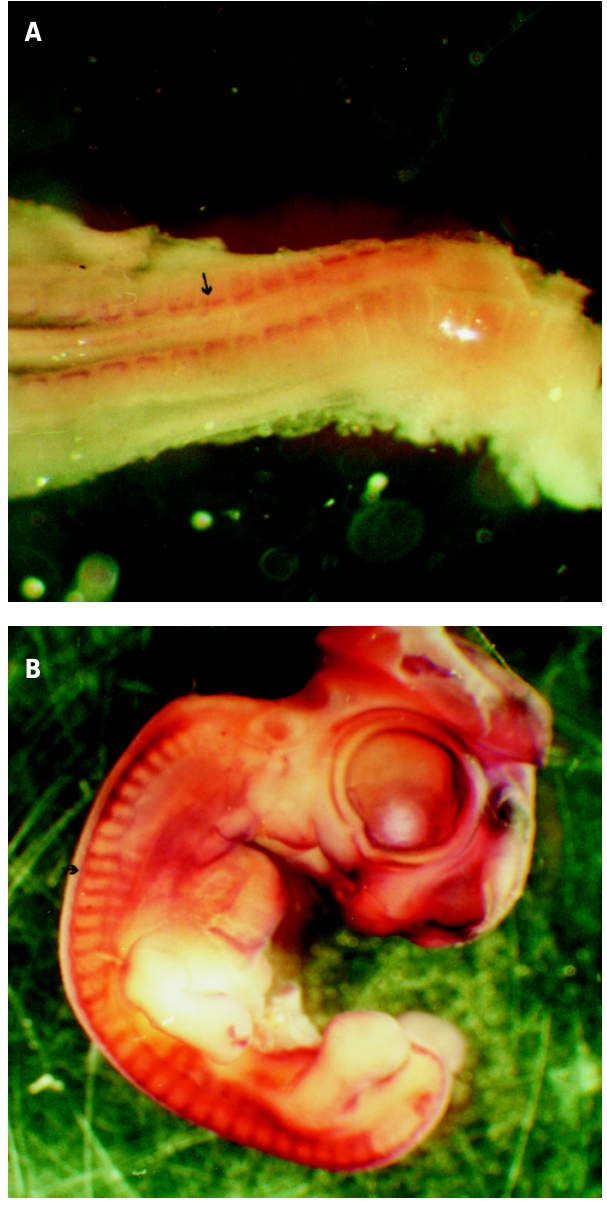
Figure 1 - MyoD expression pattern in developing chicken embryos. A and B - Whole mounts of stage 12 (two days) and stage 24 (five days) chicken embryos, respectively, hybridized in situ with digoxigenin-labelled MyoD anti-sense probe. The embryo in Figure 1A is oriented in a cranial to caudal direction from right to left. The dark brown signal (arrows) along the medial side of the somites indicates the presence of MyoD